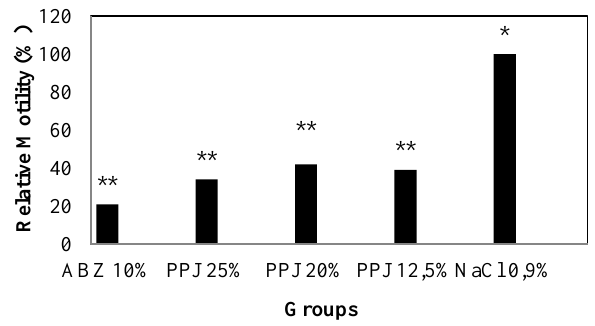
Fig. 6. RM mean of each group: * significantly different from Albendazole 10% w/v, ** significantly different from NaCl 0.9% w/v (p <0.05) Based on the statistical analysis, it shows that Albendazole and PPJ have anthelmintic effects (p <0.05). Saowakon et al. explained the anthelmintic mechanism of Albendazole with damage to adult Paramphistomum flukes. Albendazole binds to β-tubulin and interferes with the formation of flukes’ microtubules. Gradually this causes damage to the surface of the tegument, therefore water enters the surface of the tegument and causes an osmotic imbalance. Blebbing occurred in papillae around oral suction vanity